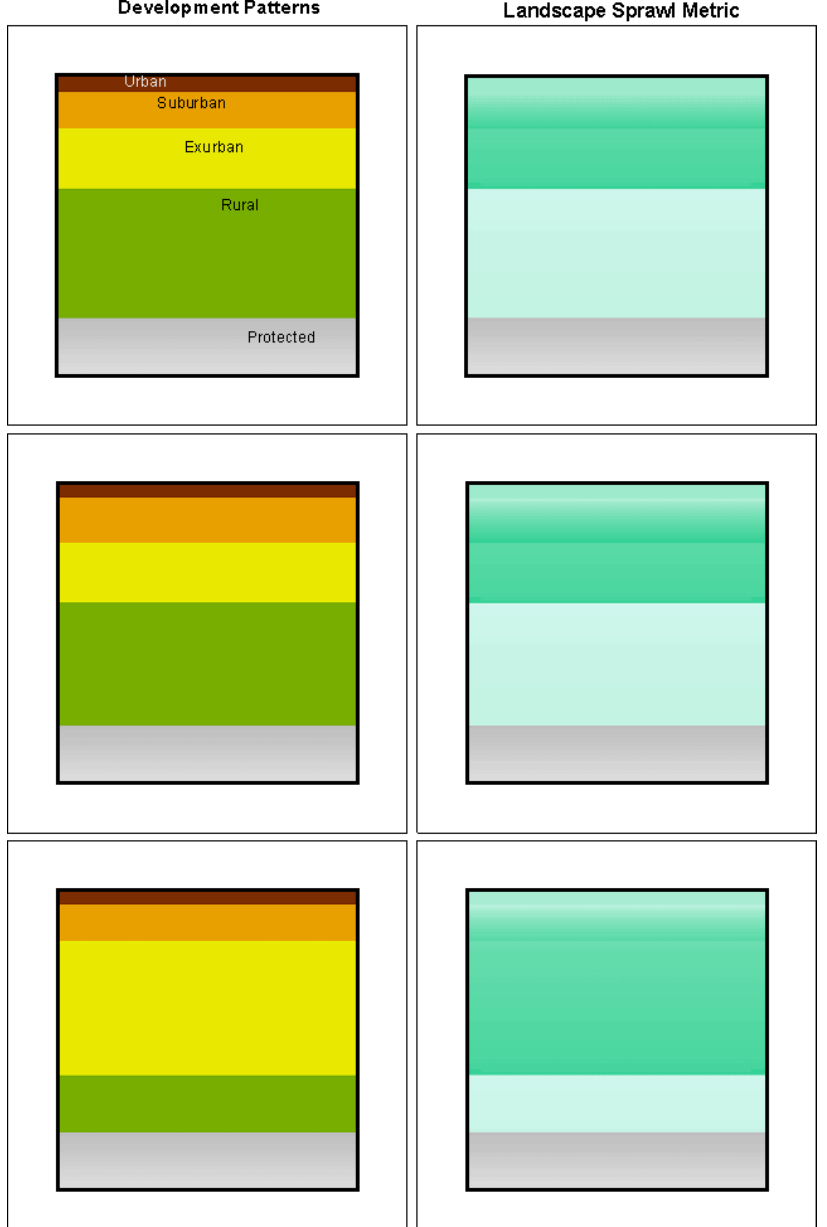
Fig. 5. The Landscape Sprawl (LS) metric also can be used to capture patterns of development over time. The scenarios here reflect a 10% increase in the original number of housing units (Fig. 3, top). Expanding the area occupied by urban housing density to accommodate the additional housing units increases LS only slightly (274.7, top, compared with 267.8 in the original). The LS metric increases to 286.7 (center) when the suburban class is expanded. LS increases to 403.1 (bottom) when the additional units are developed at exurban